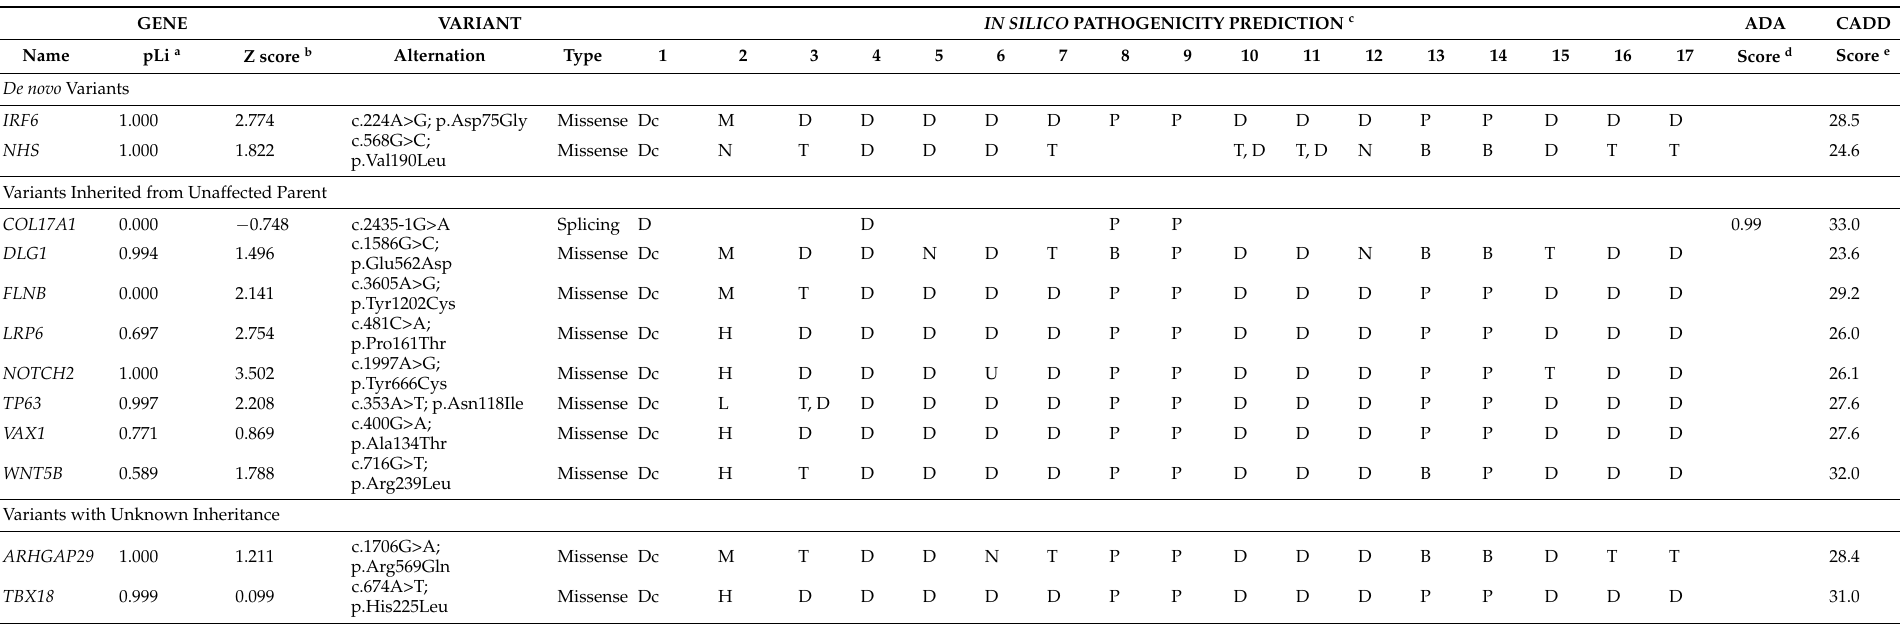
Table 3. Pathogenicity scores of variants detected in ns-CP